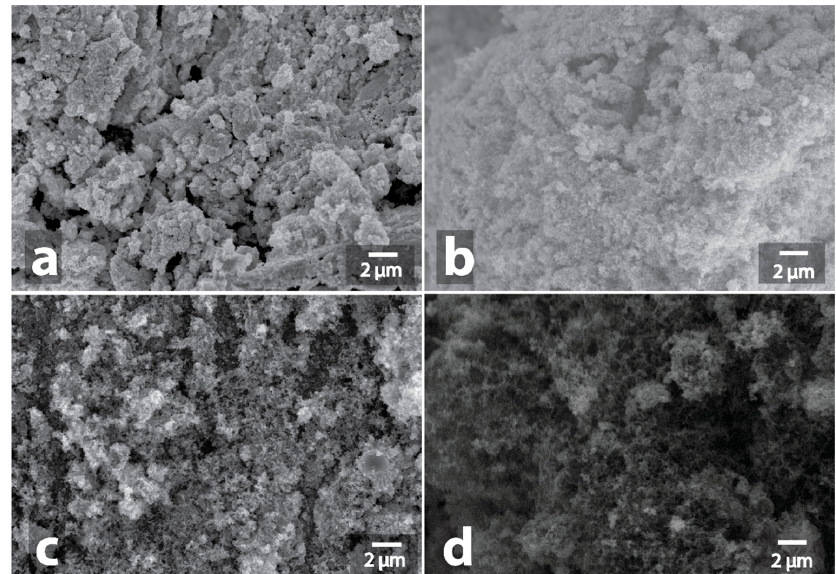
Figure 9. SEM image of initial W-C powder ( a ) and SEM image of W-C powder after MW-treatment ( b ), initial V-C powder ( c ) and SEM image of V-C powder after MW-treatment ( d ). Of all the carbon-containing samples, the reaction of Cr-C was the least violent: only weak red heating was observed. EDX study indicates the formation of oxide (Figure S87, S90). Despite the formation of green chromium oxide Cr 2 O 3 , no morphological changes were detected (Figure 10a,b, Figures S85–S90, Figure S213).